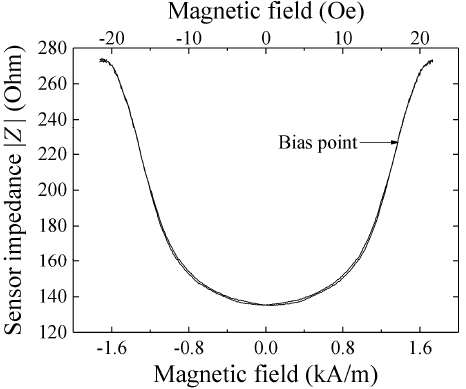
Figure 2. Typical example of variation of impedance of the sensor.